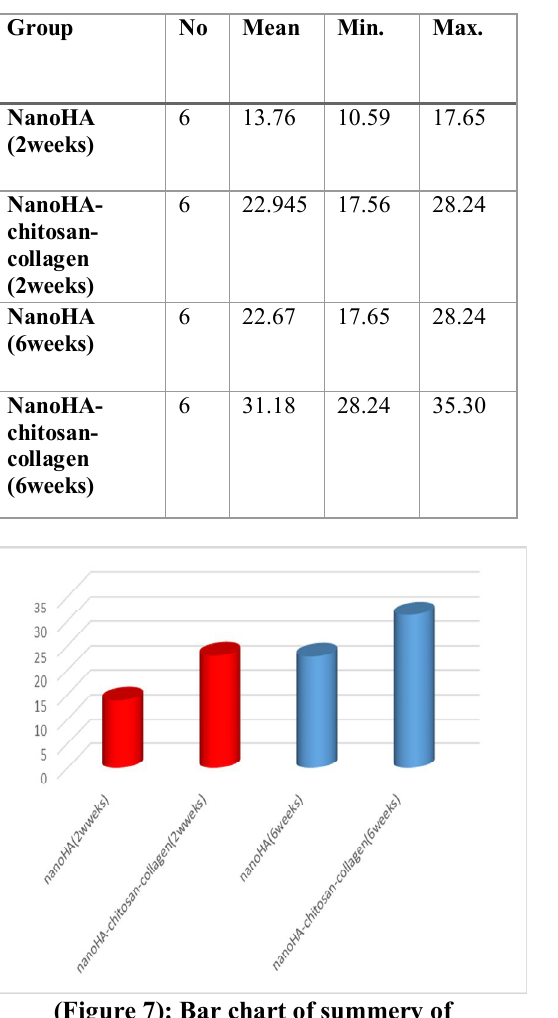
Table (2): Equality of removal torque mean of all tested groups after 2 and 6 weeks of implantation by ANOVA test